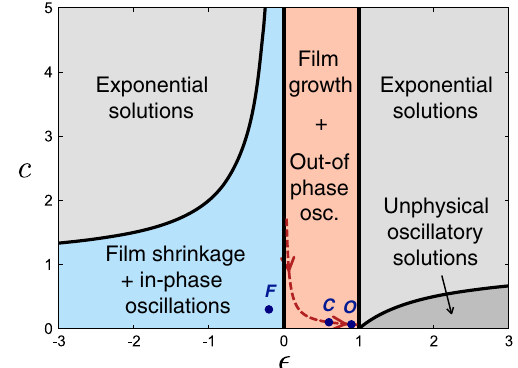
FIG. 4. Phase diagram of behavioral regimes, where ϵ ¼ μ =k r and c ¼ k r =k t . Phase boundaries are represented by solid black lines; those that are curved obey c ¼ 1 − ϵ − 1 . Blue and orange shaded regions may pertain to morphogenesis. Dark blue dots labeled C , O , and F indicate parameter values used to make the cerebellum, organoid, and fovea plots, respectively, in Fig. 2. The red dashed line (given by c ¼ 0 . 06 = ϵ ) indicates one possible trajectory of cerebellar and organoid morphogenesis, associated with k r decreasing over